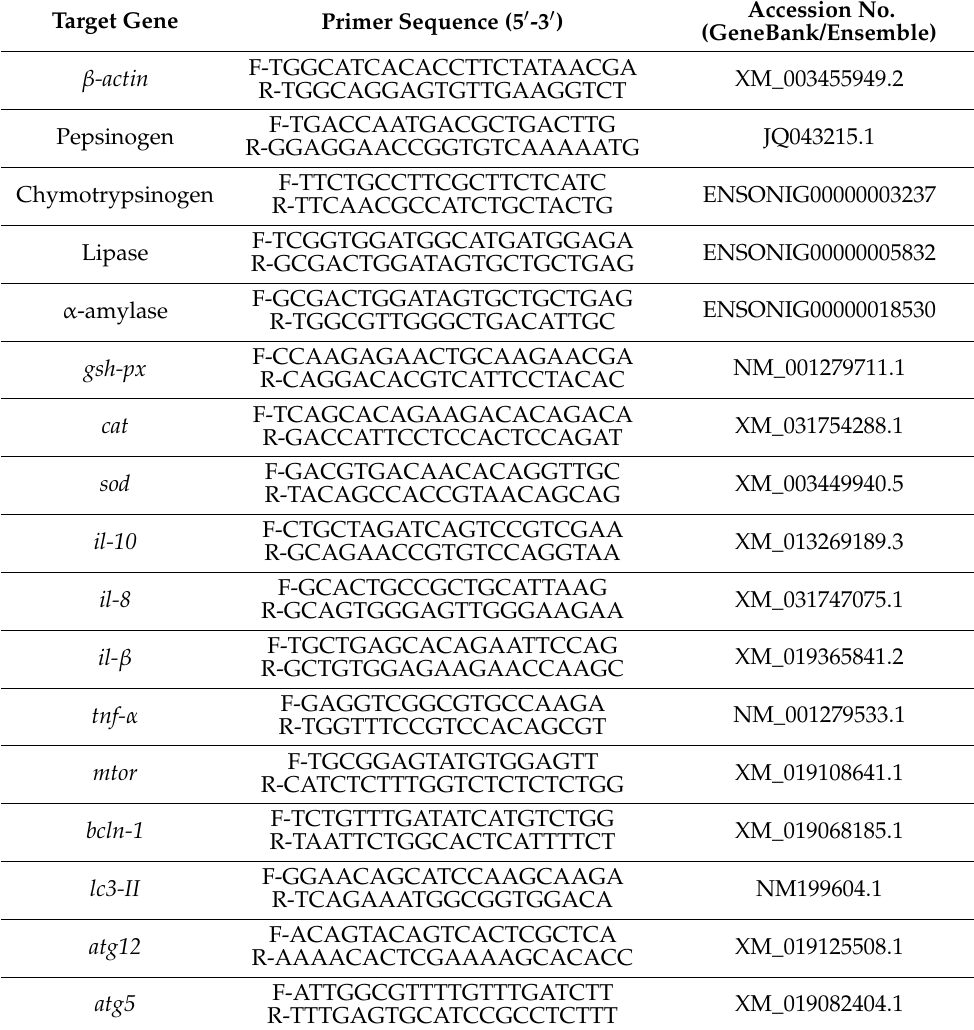
Table 2. Primers’ sequences employed for quantitative reverse transcription polymerase chain reaction